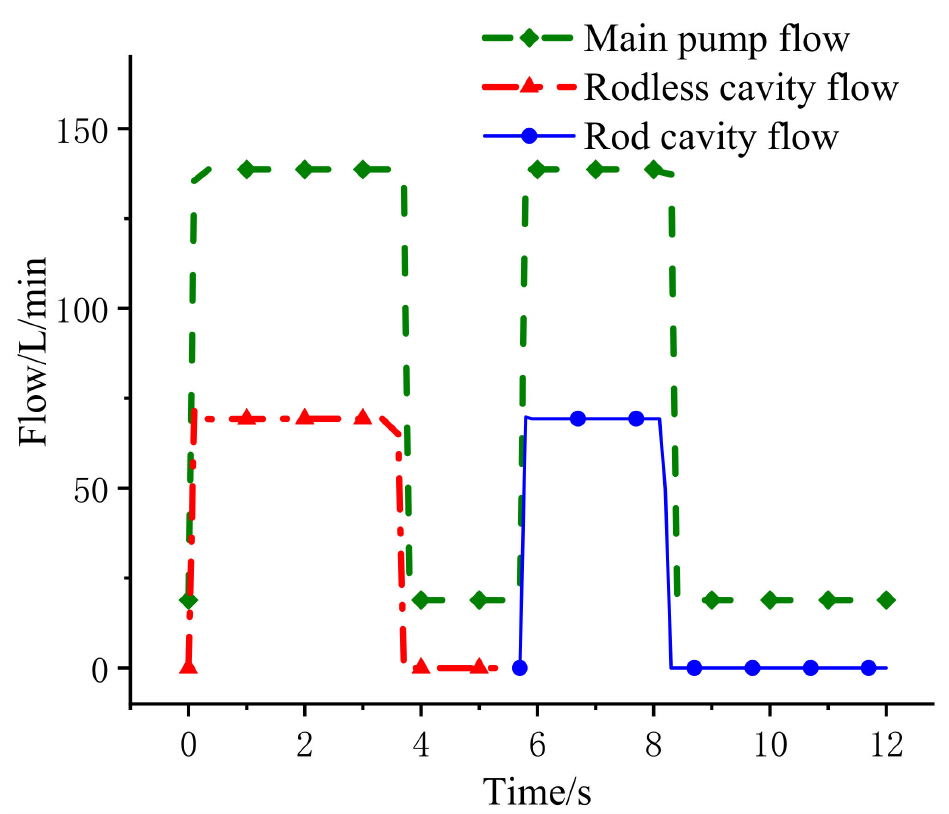
Figure 14. Relationship between the output flow of the main pump and the flow of the rodless chamber of the